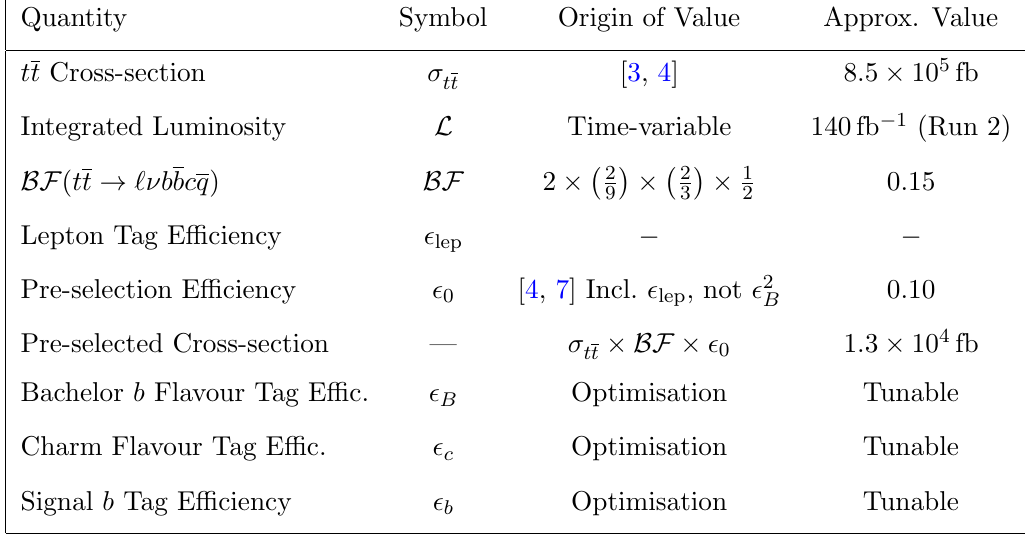
Table 1 . Input quantities for calculation of sample magnitudes. The two b -jet (cid:13)avour-tagging e(cid:14)ciencies, (cid:15) B and (cid:15) b , are kept as distinct quantities, foreseeing the possibility to tune them inde- pendently in optimising the signal